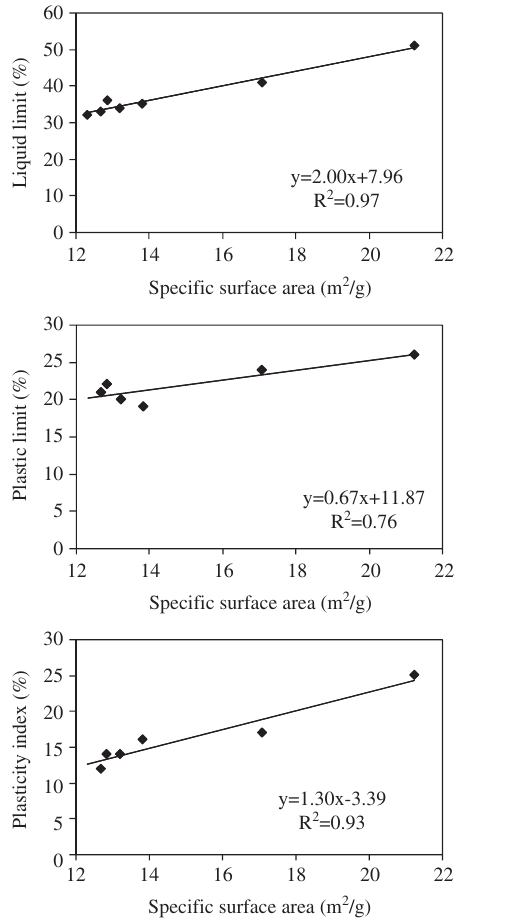
Figure 11 Relations between BET, surface area, liquid limit, plastic limit, and plasticity